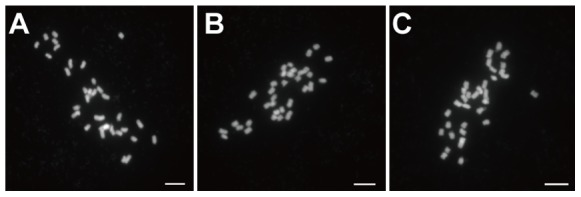
Normal chromosome numbers in selfed progeny of ‘Jin Zhui’.A, 34 chromosomes of an S21S21 homozygote representing a total of 12 progeny examined. B. 34 chromosomes of an S21S34 heterozygote representing a total of 21 progeny examined. C. 34 chromosomes of an S34S34 homozygote representing a total of 13 progeny examined. Scale bar: 5 µm.